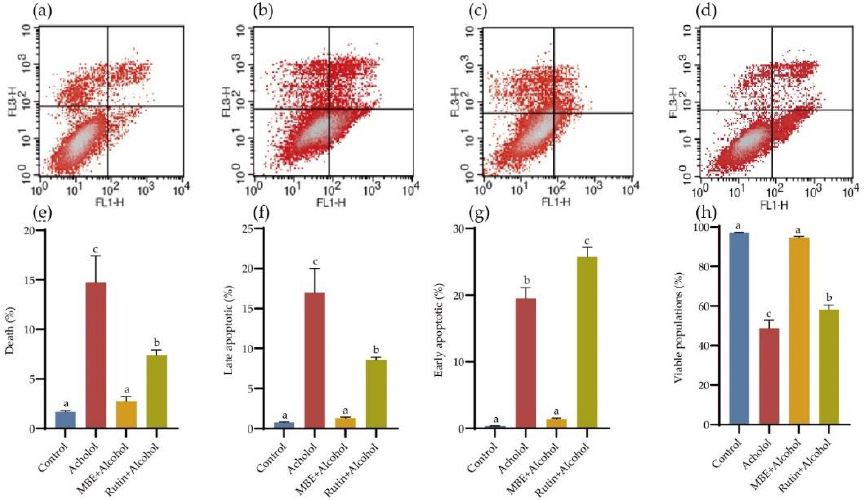
Figure 4. MBE and rutin can reduce alcohol-damaged GES-1 cell apoptosis. Flow cytometry was used to detect cell apoptosis. ( a ) Control; ( b ) Alcohol; ( c ) MBE + Alcohol, GES-1 cells were pretreated with 400 μg/mL MBE for 24 h, then treated with 500 mM alcohol for 4 h; ( d ) Rutin + Alcohol, GES-1 cells were pretreated with 320 μM rutin for 24 h, then treat with 500 mM alcohol for 4 h; ( e – h ) Effects of MBE and rutin on apoptosis of GES-1 cells, Compared with Control group. Different letters indicating significant differences labeled at the inhibitory activity at different compounds ( p <